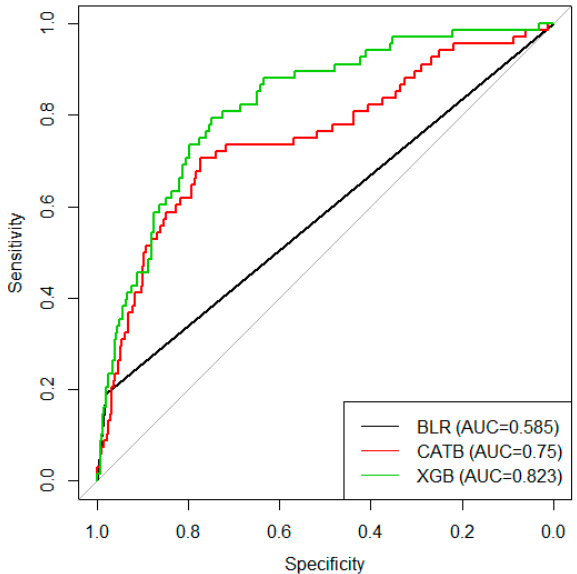
Figure 2. Results of the area under the receiver operating characteristic curves showing the performance of the binary logistic regression, catboost, and xgboost machine algorithms to predict high coronary artery calcium scores. BLR, binary logistic regression; CATB, catboost; XGB, xgboost; AUC, area under the receiver operating characteristic curves.